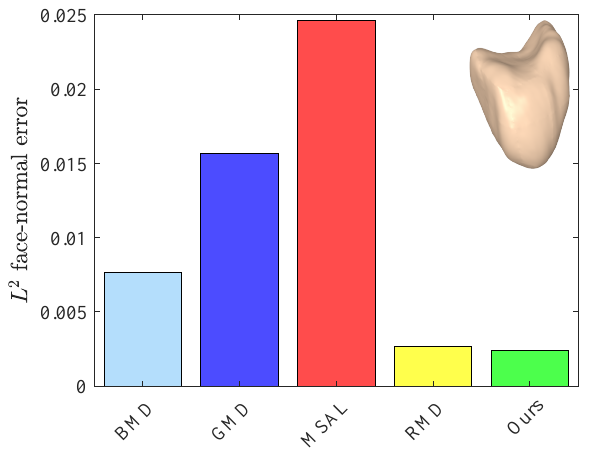
Figure 11. L 2 face-normal errors for the lunate model.